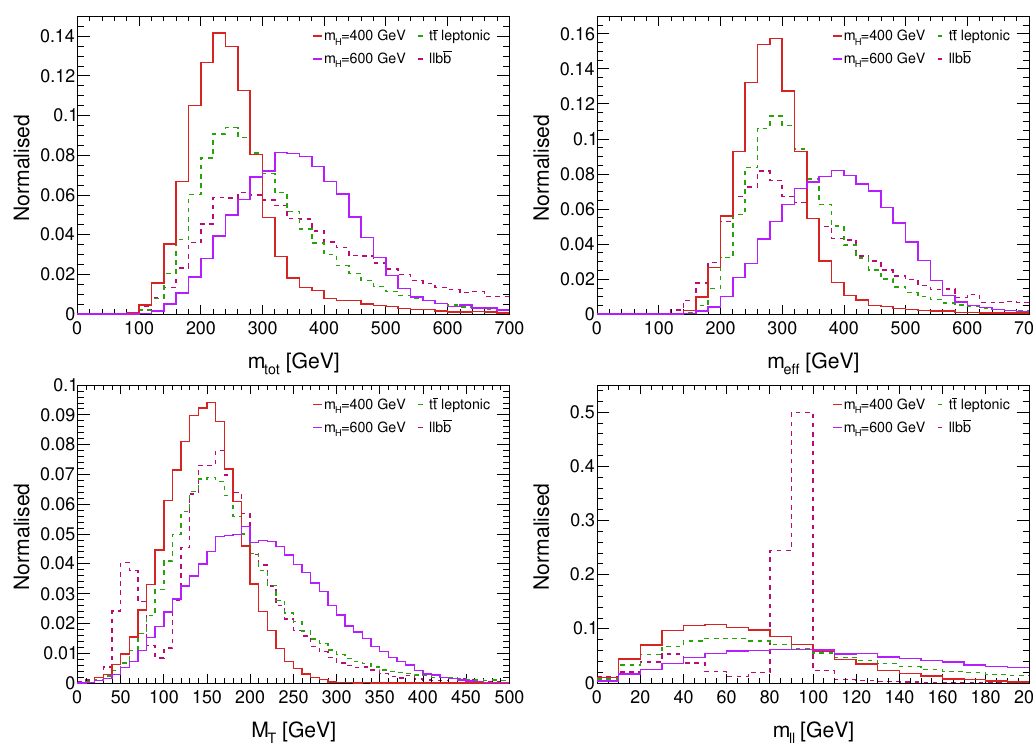
Figure 30 . The m tot , m e(cid:11) , M T and m ‘‘ distributions for the 2 ‘ category for m H = 400 and 600 GeV with dominant backgrounds. Here the heavy Higgs boson is searched for in the t (cid:22) t channel. The distributions are shown before doing the multivariate analysis.